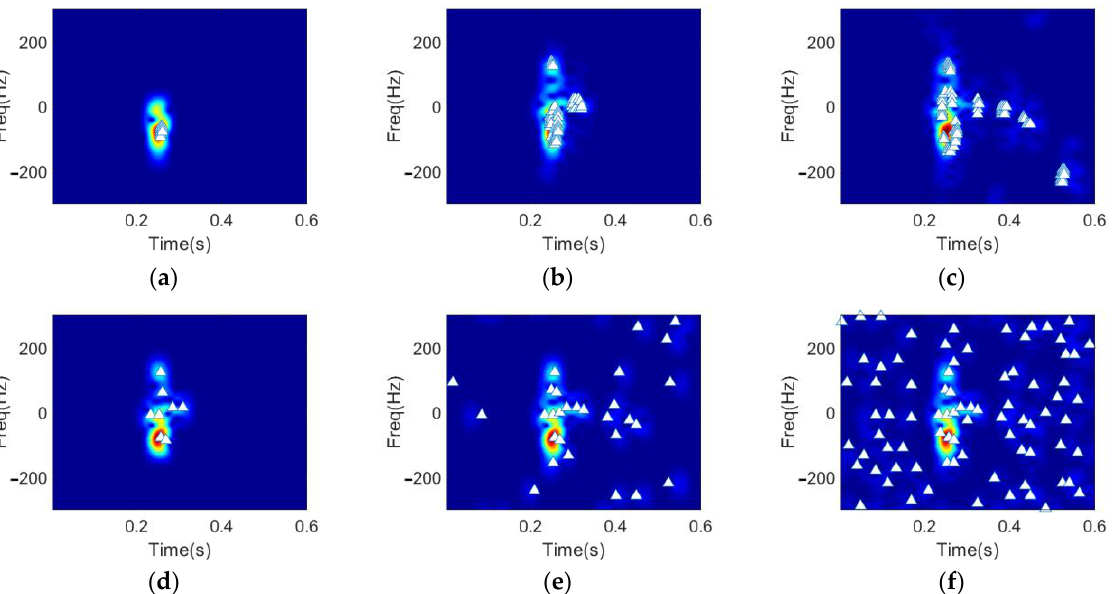
Figure 11. Feature vectors and the corresponding time-frequency distributions based on DGS-SP: ( a – c ), and OMP: ( d – f ), with the sparsity levels chosen as 8, 48, and 128, respectively.